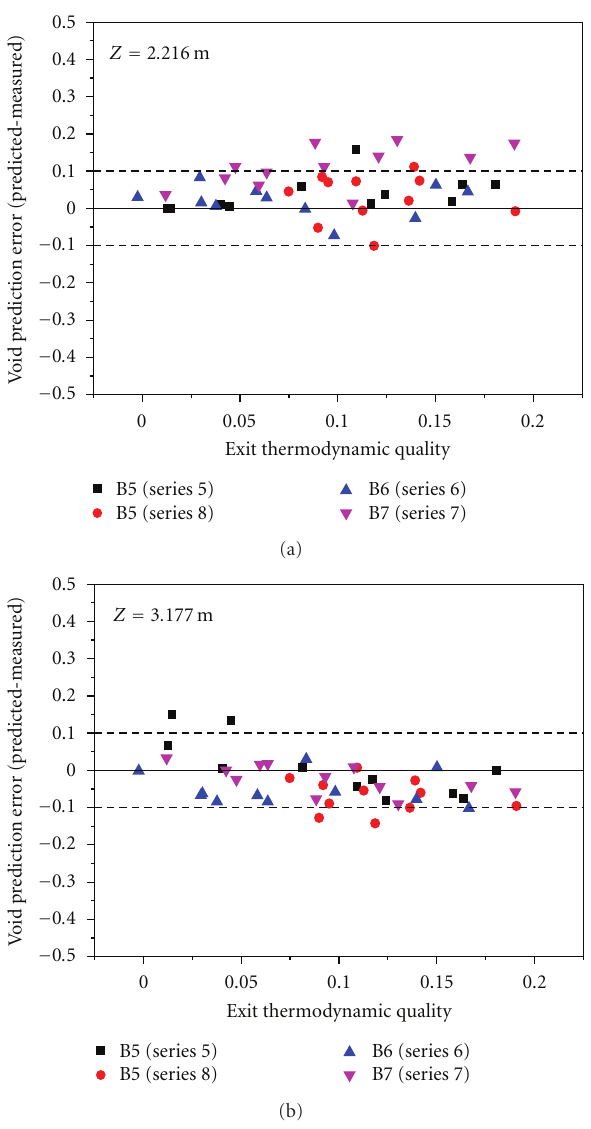
Figure 3: Prediction accuracy of subchannel void fraction at various elevations.